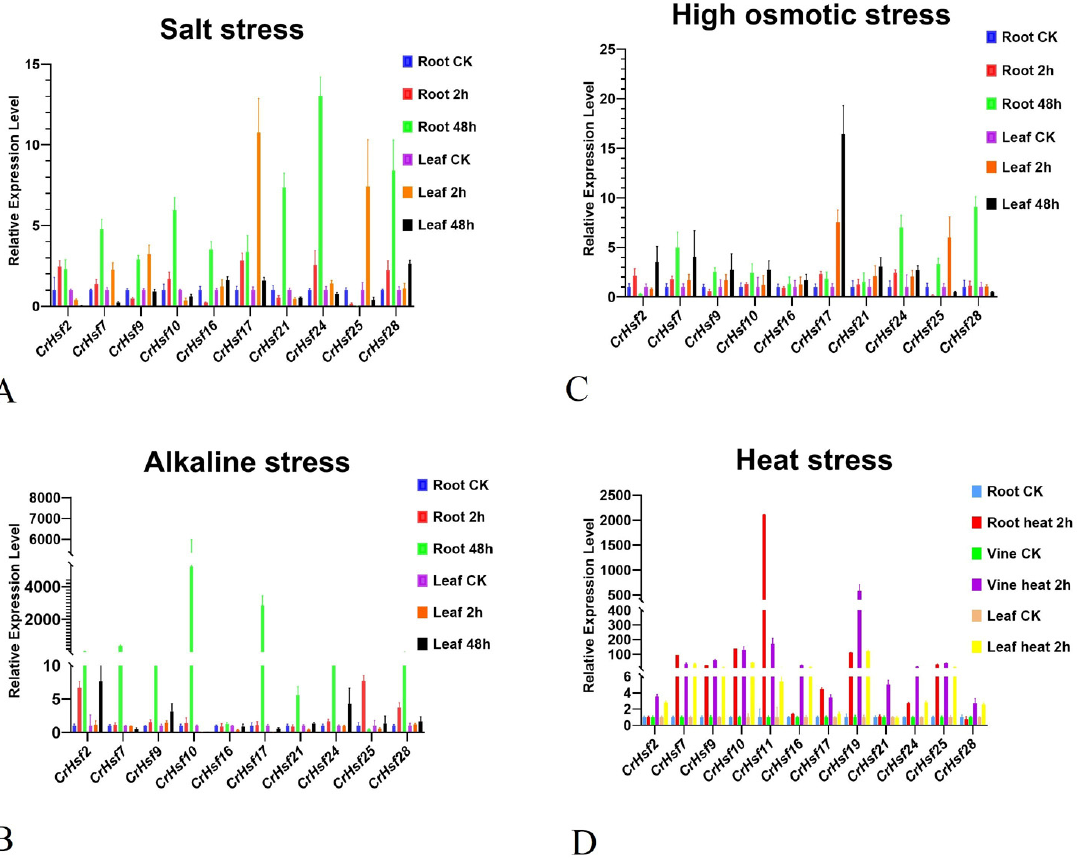
Figure 8. Tempo-spatial expression analysis of the 10 CrHsf genes with quantitative reverse tran- scription PCR (qRT-PCR) responding to different stresses: ( A ) The relative expression patterns of 10 CrHsf genes under salt stress (150 mM NaCl); ( B )alkaline stress (NaHCO 3 ); ( C ) high osmotic stress (300 mM mannitol); ( D ) heat stress (45 °C), in C. rosea seedling plants. Relative expression values were calculated using the 2 −Δ Ct method with the housekeeping gene CrEF-1 α as the reference gene.